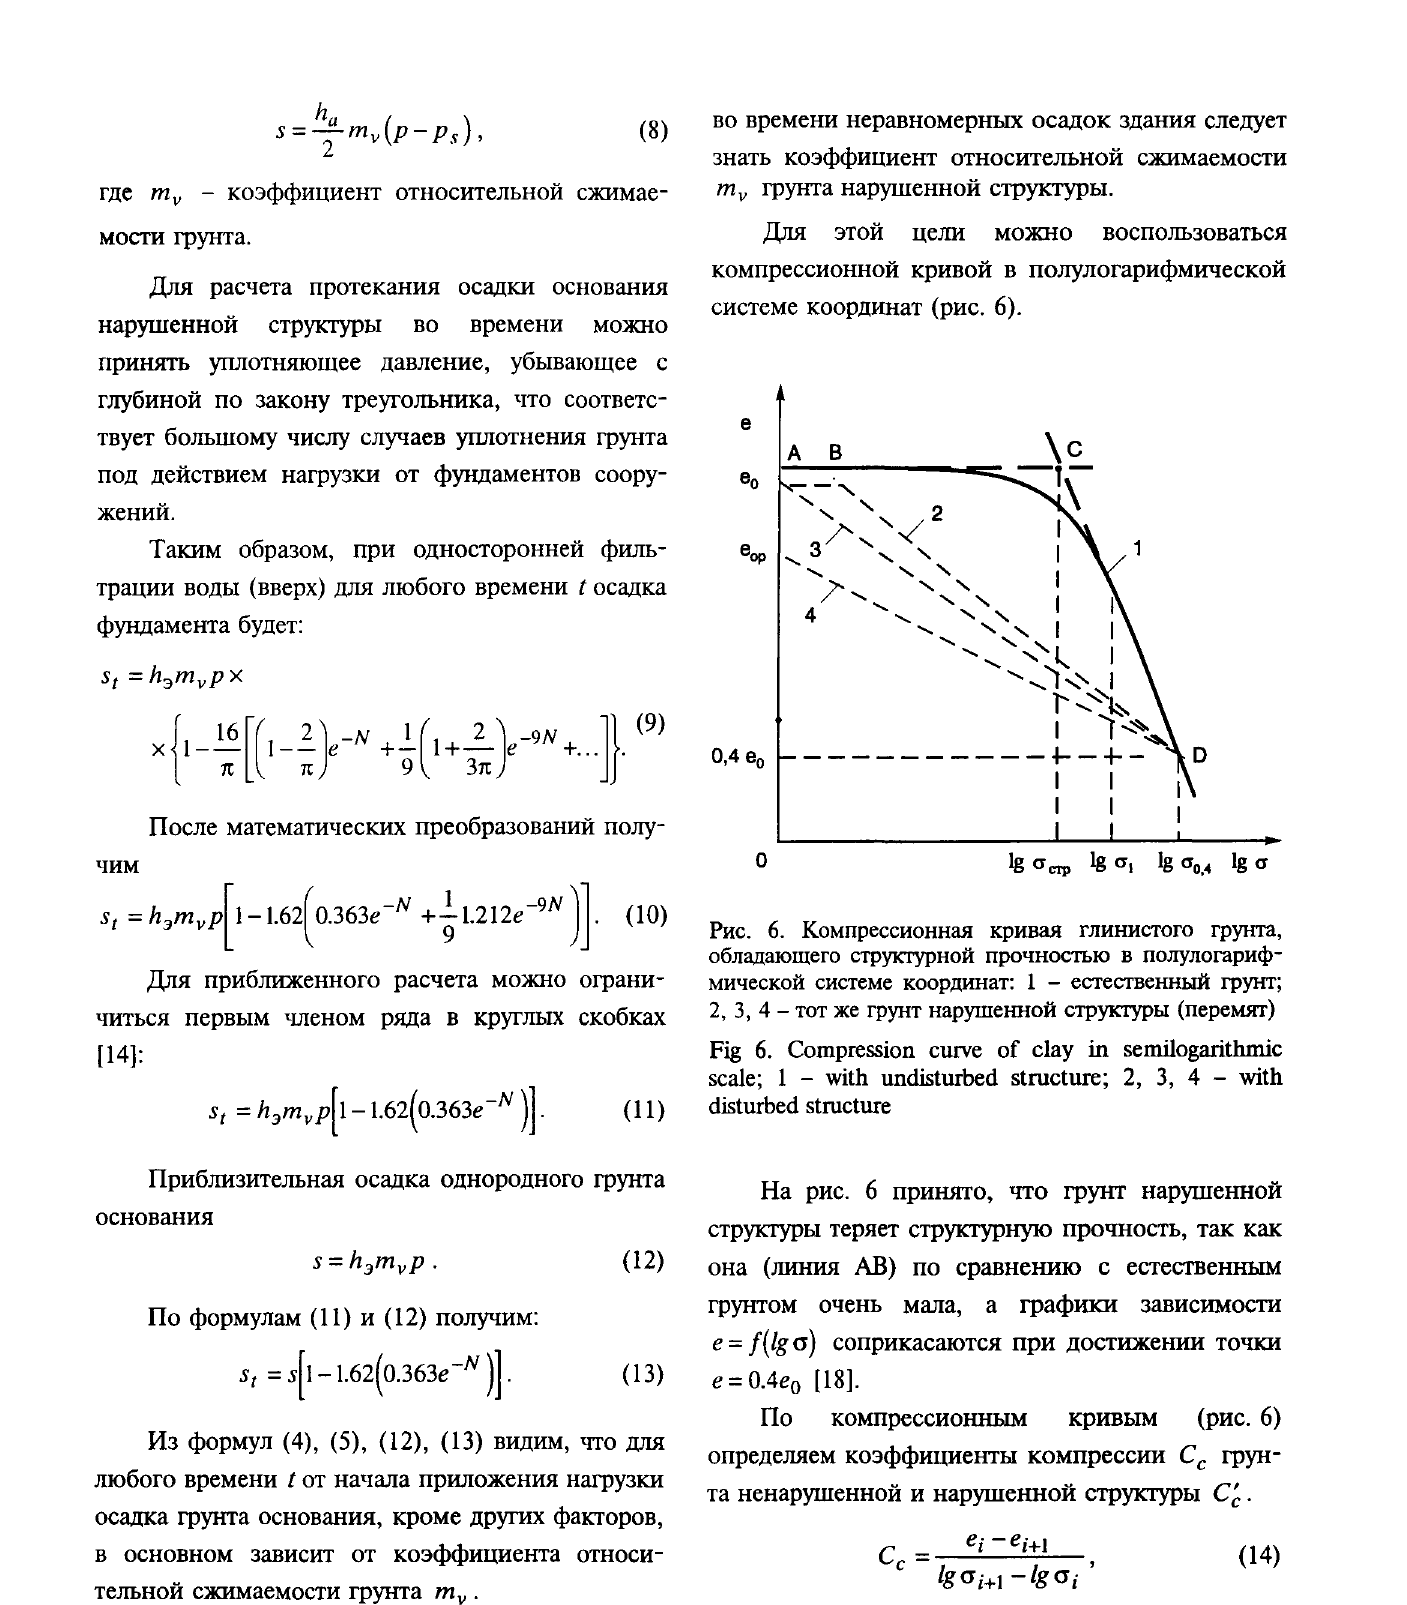
Fig 6. Compression curve of clay in semilogarithmic scale; 1 - with undisturbed structure; 2, 3, 4 - with disturbed